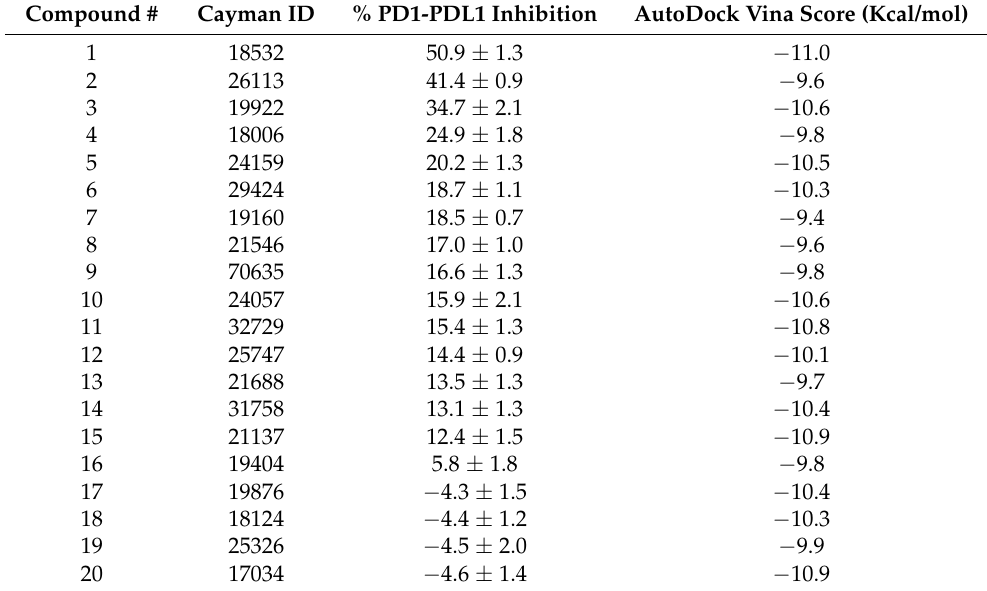
Table 2. Top 20 virtual hits tested in the HTRF PD1-PDL1 binding assay, together with their AutoDock Vina docking